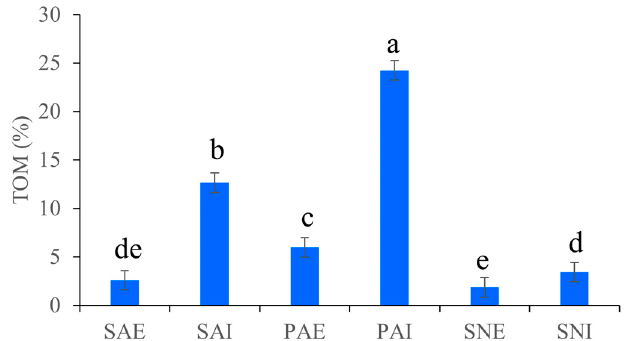
Figure 1. Total organic matter (TOM) content in gut contents and surrounding sediments of S. australe, P. arcuatum, and S. nudus. The different letters indicate significant differences among samples ( p < 0.05). The gut contents and surrounding sediments of S. australe, P. arcuatum, and S. nudus are, respectively, marked as SAI, PAI, SNI, SAE, PAE, and SNE.